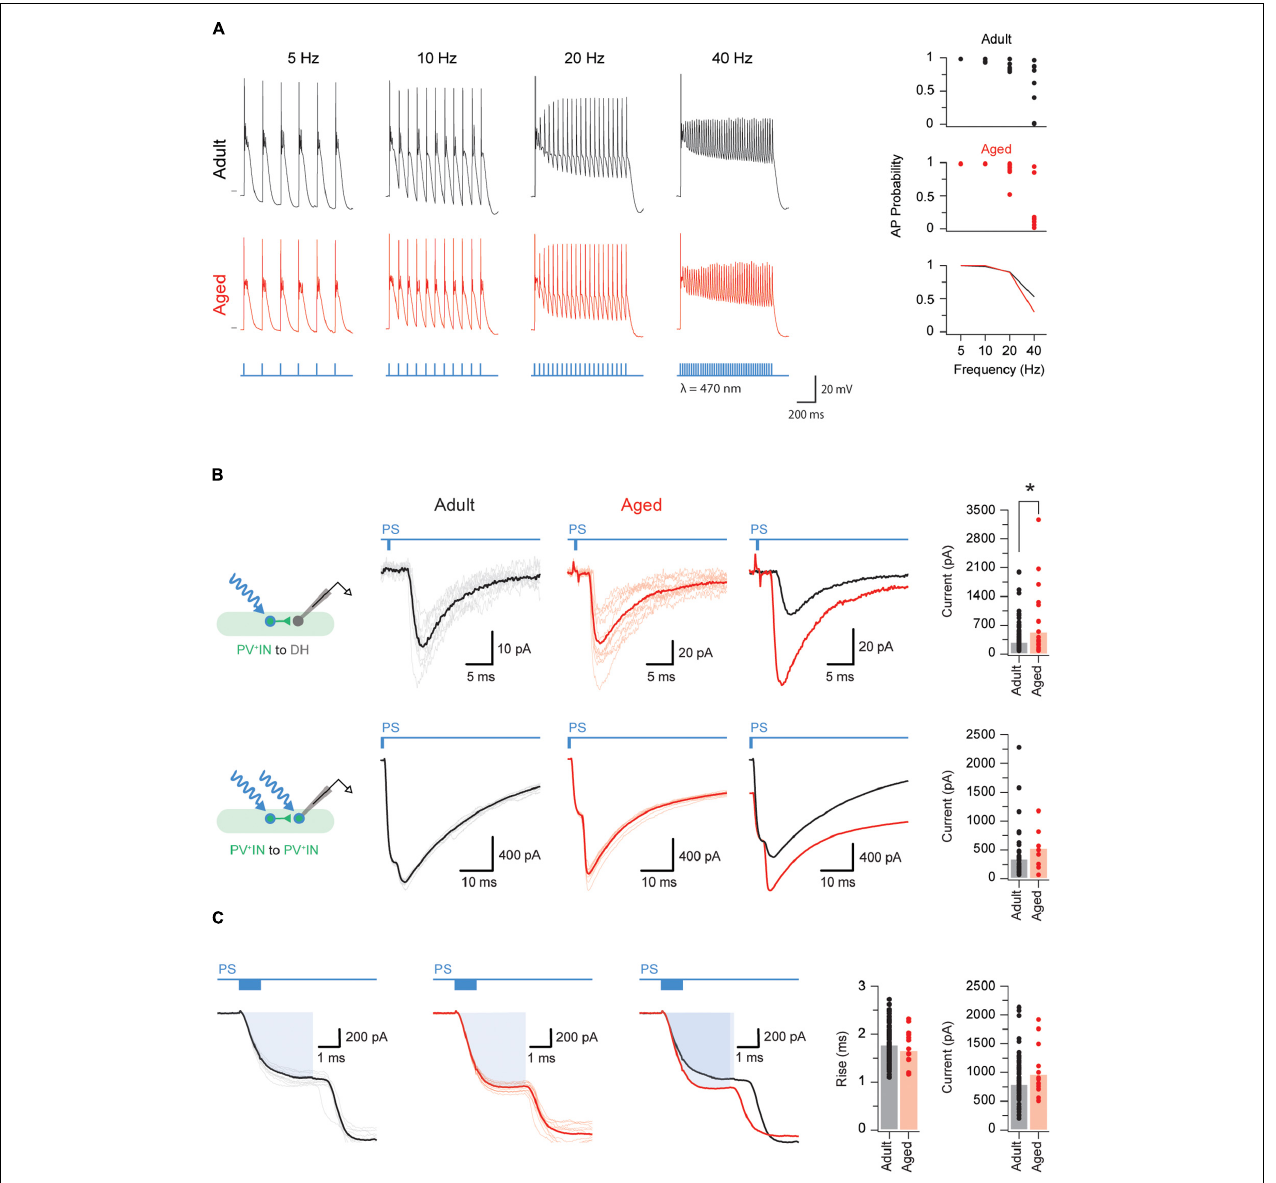
FIGURE 4 | Aged PVINs increase their postsynaptic output. (A) Traces showing photostimulation-evoked AP discharge in adult and aged PVINs at increasing stimulation frequencies. Photostimulation pulses (1 ms duration) and stimulation protocol are shown in blue. The short horizontal black bars on the 5 Hz discharge traces indicate a membrane potential of − 60 mV. Top two plots on the right summarize the reliability of evoked AP discharge at the four photostimulation frequencies for adult and aged PVINs. Bottom graph compares the mean probability for AP discharge at different photostimulation frequencies. (B) Voltage clamp recordings ( − 70 mV holding potential) showing PVIN photostimulation-evoked inhibitory postsynaptic currents (oIPSCs) generated in unidentified neurons (top traces) and PVINs (bottom traces). Schematics to the left show each photostimulation and recording configuration. Left traces are recorded from adult mice, and middle traces from aged mice (10 consecutive sweeps and average overlayed in each). Right traces show overlaid averages. Note, oIPSC responses are markedly larger at PVIN to unidentified cell connections in aged animals. Group data plots (far right) compare oIPSC amplitude for each recording configuration and show that oIPSC amplitude is increased at PVIN to unidentified cell connections in aged mice. (C) Voltage clamp recordings ( − 70 mV holding potential) from adult (left) and aged (middle) PVINs on an expanded time scale to show the photocurrent phase of the photostimulation response (highlighted by blue rectangle). Average overlaid photocurrent responses (right trace) show they are similar in recordings from adult and aged animals. Group data (far right plots) compare photocurrent rise time and amplitude in adult and aged PVINs. The similarity in these two measures suggest age related changes in photocurrent properties does not explain the larger oIPSCs observed at PVIN to unidentified cell connections in aged mice. Each data point represents the mean of 10 consecutive traces events. * p < 0.05.